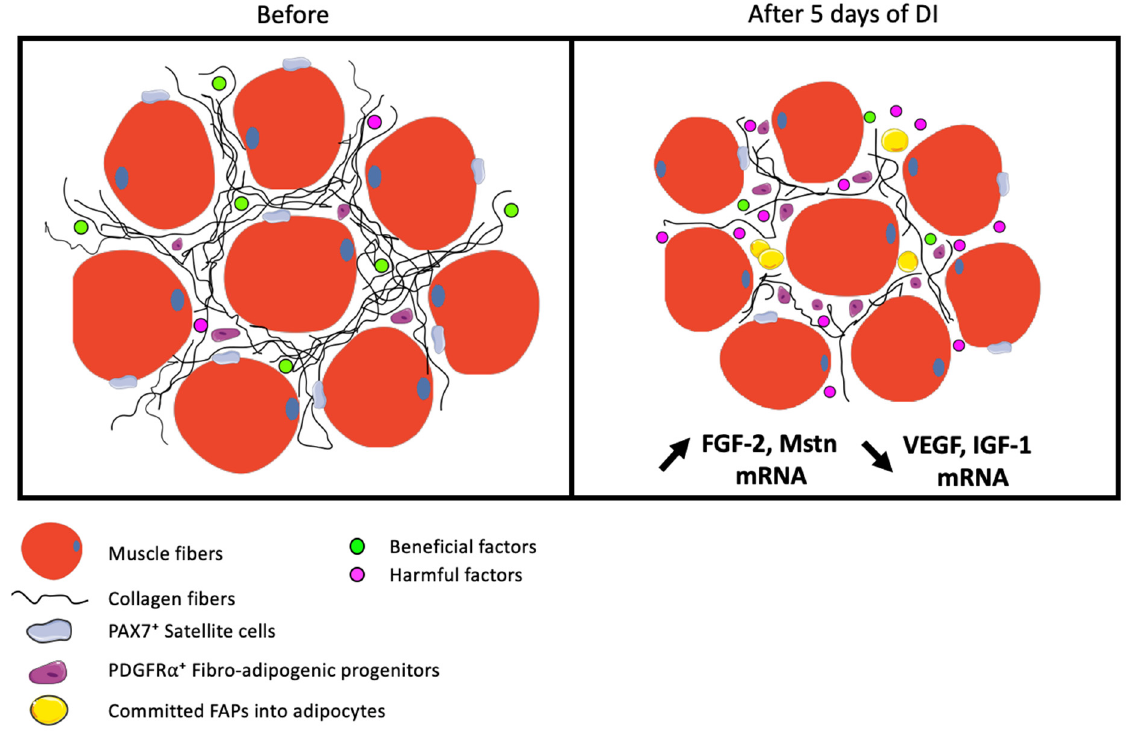
Figure 6. Muscle microenvironment degradation after 5 days of DI in healthy men. DI leads to a decrease in muscle fibers area as well as disorganization of ECM structure with reduced collagen and fibrosis content. After DI, ECM modulation, as well as atrophy, seems to drive a shift toward harmful signals resulting at least in FGF-2 and Myostatin signaling increases and VEGF and IGF-1 decreases. We hypothesized that these early changes dynamically stimulate muscle resident cells, impairing PAX7 ⁺ muscle progenitors (SCs) number and promoting PDGFRa ⁺ Fibro-adipogenic progenitors (FAPs) proliferation and differentiation into mature adipocytes. Thus, ECM reorganization seems to be a critical regulator of resident cell fate and behavior.